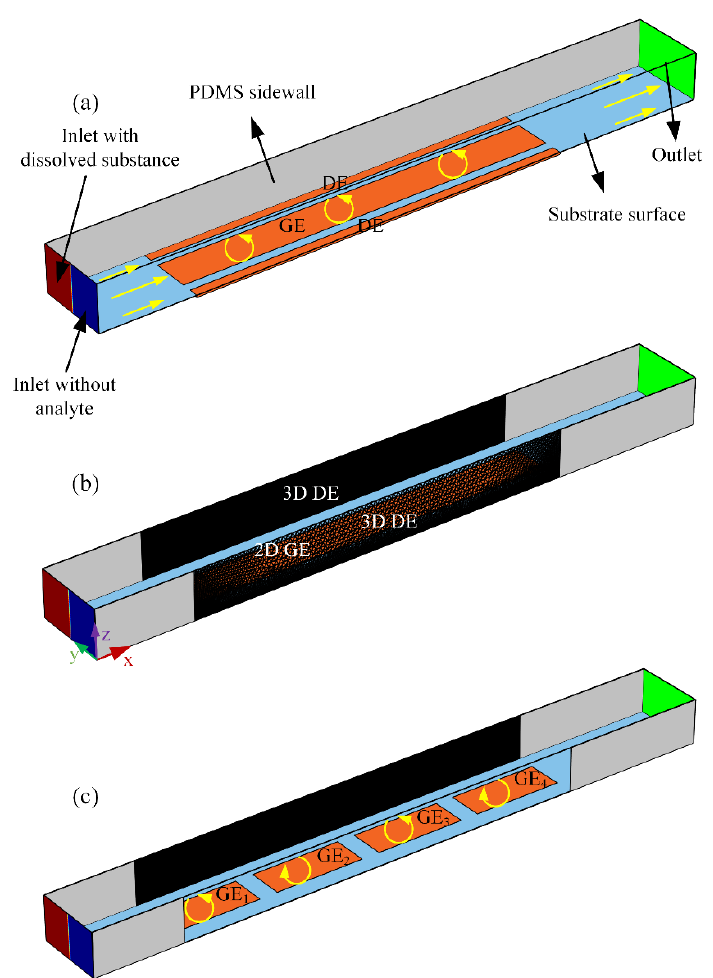
Figure 1. Device design of field-effect-reconfigurable ICEO micromixer with the configuration of three parallel metal strips. ( a ) An AC-flow-FET micromixer using 2D electrode structures, in which the co-flowing laminar streams intersect perpendicularly with the transversal asymmetric ICEO whirlpool, rending the two-phase contact interface rotate in counterclockwise direction on the surface of the central GE strip, helping mingle the analyte carried by the incoming pressure-driven flow to certain extent; ( b ) An ICEO micromixer in 3D electrode configurations, in which a pair of 3D sidewall DE is in perpendicular orientation to the flat GE metal strips placed along the centerline of channel bottom surface, this can greatly enhance the device performance compared with its 2D counterpart ( a ), taking into account the vanishing ACEO on DE and enhanced double-layer polarization on GE. ( c ) An integrated high-throughput ICEO micromixer with 3D electrode layouts, where four GE are disposed sequentially along the channel length direction, and controlled by two oppositely polarized gate terminals. It is noteworthy that the rotating direction of ICEO micro-eddy on each individual GE can be arbitrarily adjusted by applying different gate polarity, so as to spin and enlarge the diffusing phase boundary more efficiently and lead to better mixing performance than that of only having one gate terminal ( b ).